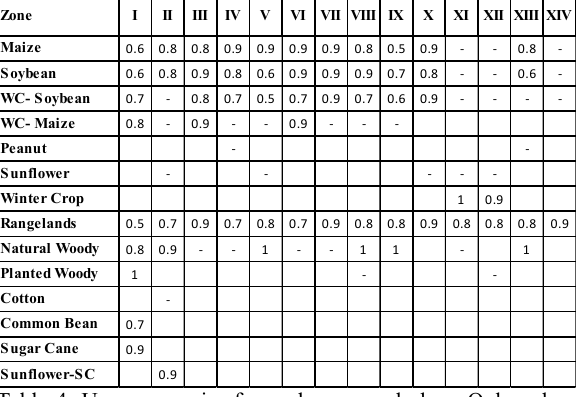
Table 4. User accuracies for each zone and class. Only values from classes with more than 20 samples are shown.